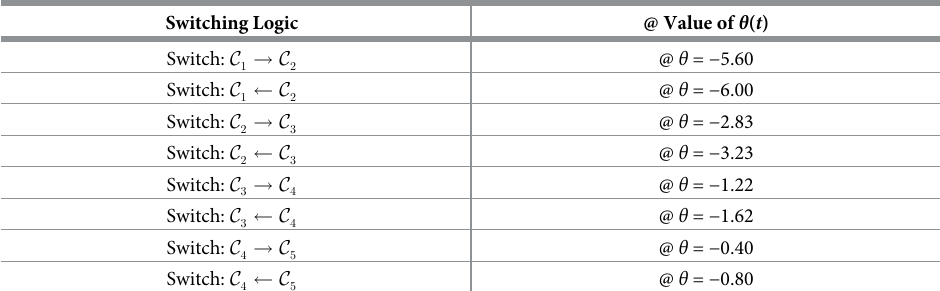
Table 1. Hysteresis based supervisory controller